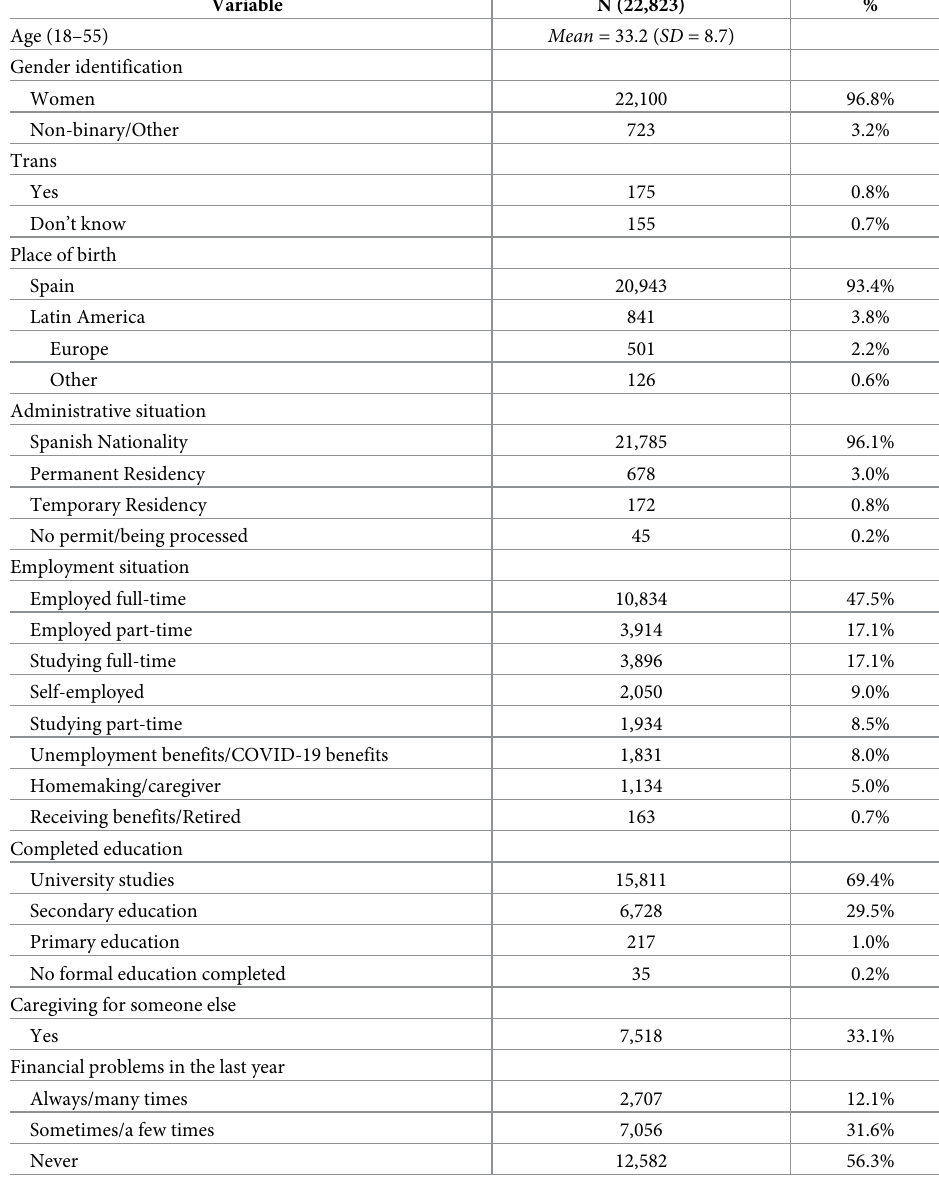
Table 1. Sociodemographic characteristics quantitative study (N =